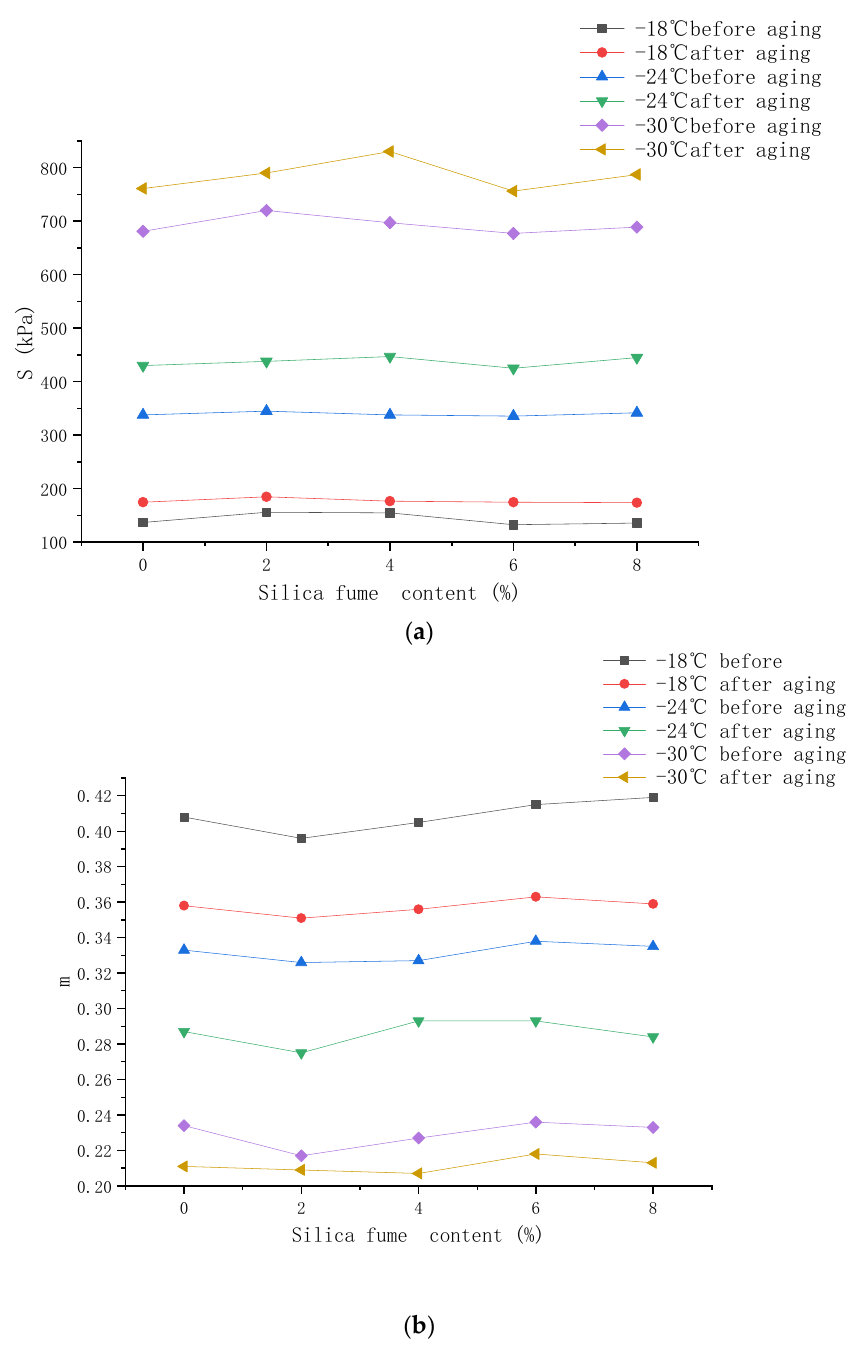
Figure 3. ( a ) Creep stiffness modulus (S) of the asphalt before and after aging; ( b ) creep rate (m) of the asphalt before and after aging.